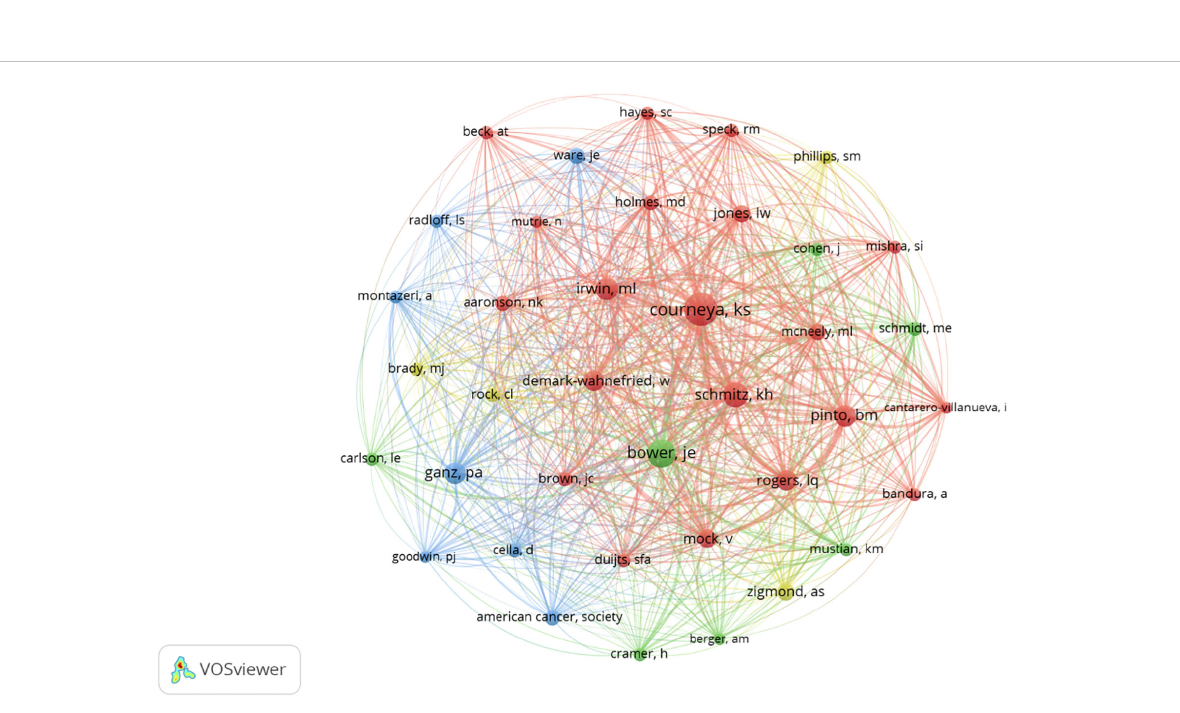
FIGURE 6 Graph with the most co-citated